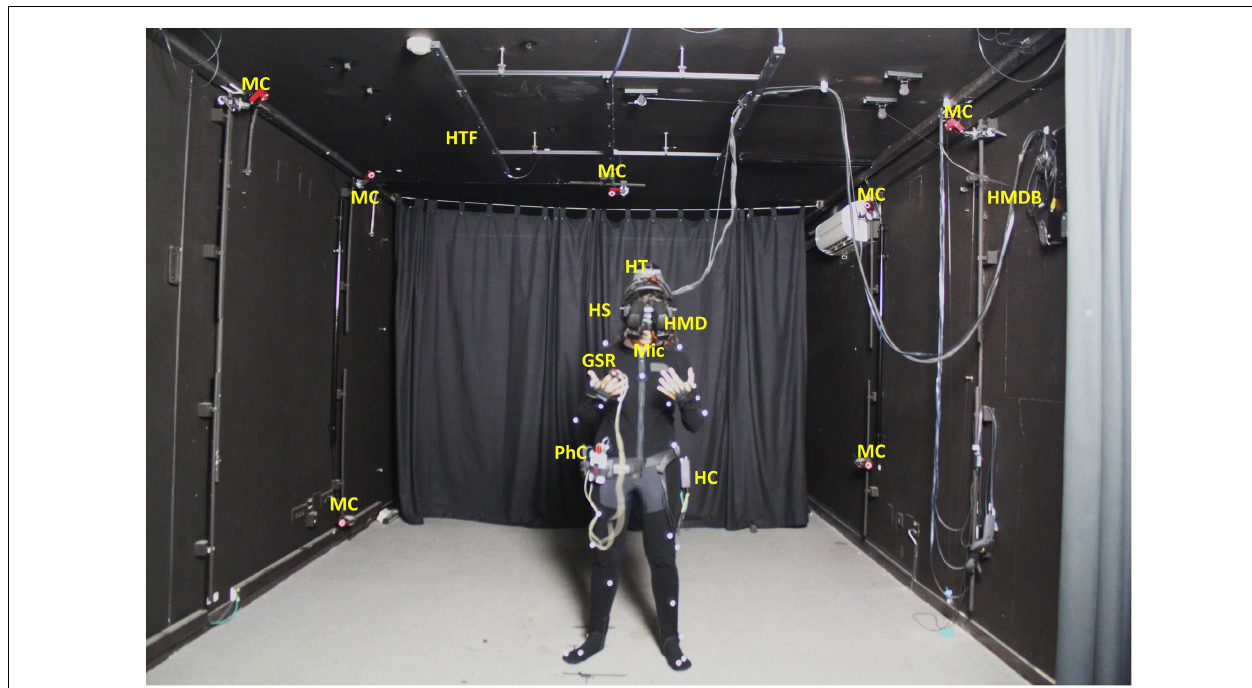
inside the motion capture jacket to deliver some sense of touch. ECG and EMG sensors are not visible in the image. Respiration is typically measured with an elastic belt around the chest. In the room, which is painted black to overcome possible lighting distractions, there are 12 Optitrack motion capture cameras (MC), 7 of which are visible in the image. An Intersense IS-900 head-tracking frame (HTF) installed on the ceiling sends out ultrasound signals in order for the system to capture very accurate head position and